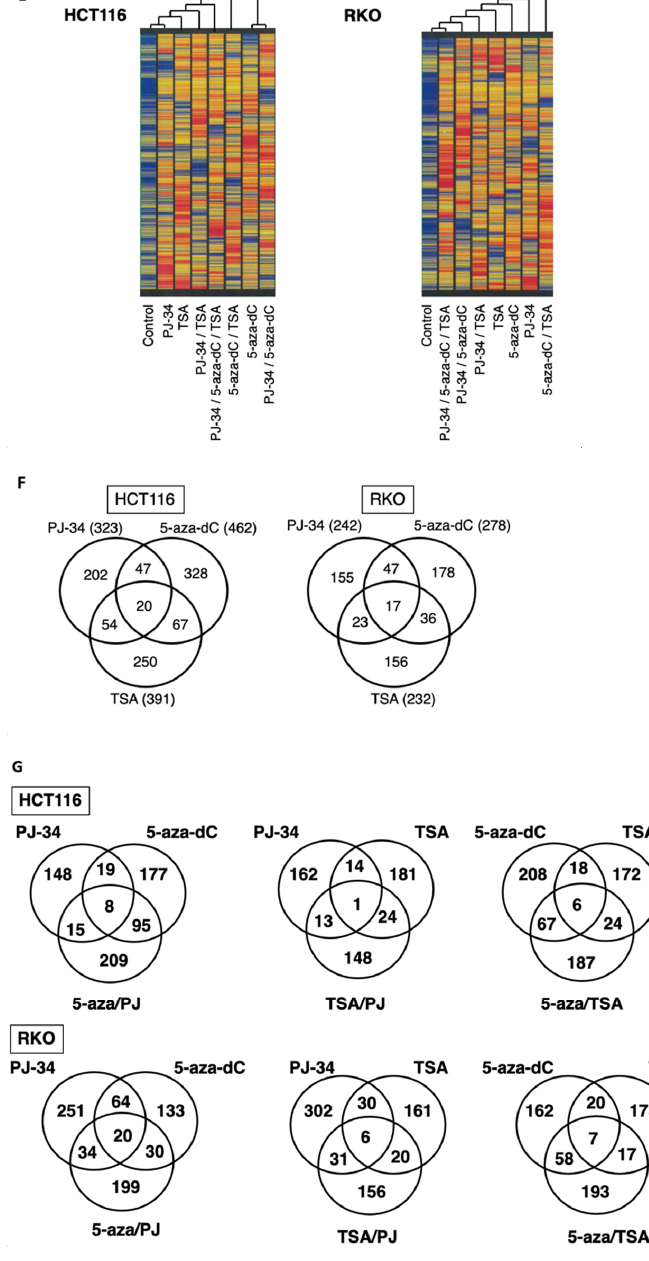
Figure 4. Effect of PJ-34 and 5-aza-dC on the gene expression profiles in HCT116 and RKO cells. HCT116 and RKO cells were treated with 5-aza-dC (5-aza) at 0.5 µM, PJ-34 (PJ) at 3 µM, TSA at 150 nM as a single treatment or in combinations for 3 days and the gene expression profiles were analyzed by microarray analysis. ( A ) Cluster analysis of gene expression profiles in HCT116 and RKO cells. ( B ) Cluster analysis of the gene expression profiles in HCT116 using 12,765 genes chosen. ( C ) Venn diagrams for genes showing 5-fold changes or more compared with the untreated condition in HCT116 and RKO cells. ( D ) Number of genes showing up-regulation by the single treatments with PJ-34, 5-aza-dC, and TSA in HCT116 and RKO cells ( A ) 16-fold or more; ( B ) 32-fold or more). ( E ) Left panel: Cluster analysis of reactivated genes that were induced by PJ3-4, 5-aza-dC, TSA, and their combinations in HCT116 cells (7742 genes chosen). Right panel: Cluster analysis of reactivated genes by PJ-34, 5-aza-dC, TSA, and their combinations in RKO cells (7720 genes chosen). Genes which showed a control level of raw data lower than 50 and showing reactivation that was 5-fold or more to reach at least to raw data of 50 in at least one single treatment condition were used. ( F )